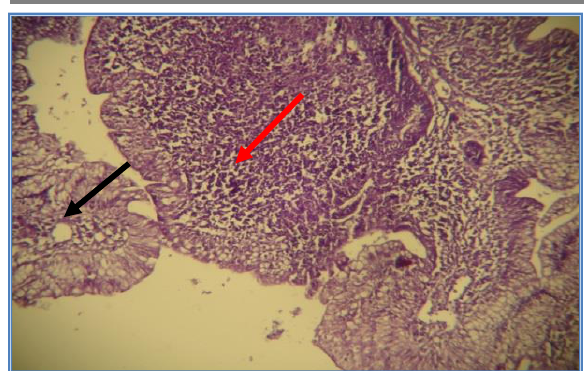
Figure, 5: Intestine of 2ndgroup after 120hrs. heat exposure showed moderate lymphocytic hyperplasia in the sub - epithelial layer ( ) and moderate cellularity of lamina propria ( ) (H and E stain 100X).